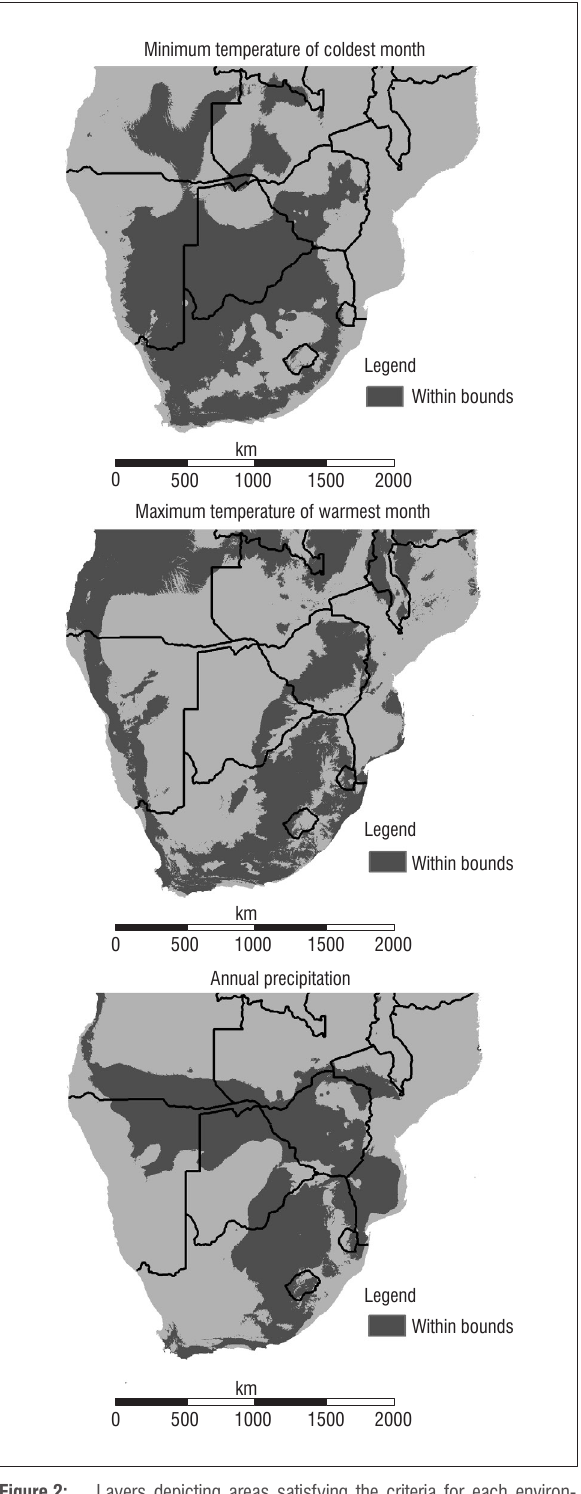
mental variable. These areas are considered within bounds if the locations fall between the 25th and 75th percentiles of the distribution spanned by the observation locations and the 2.5-km buffer zones surrounding